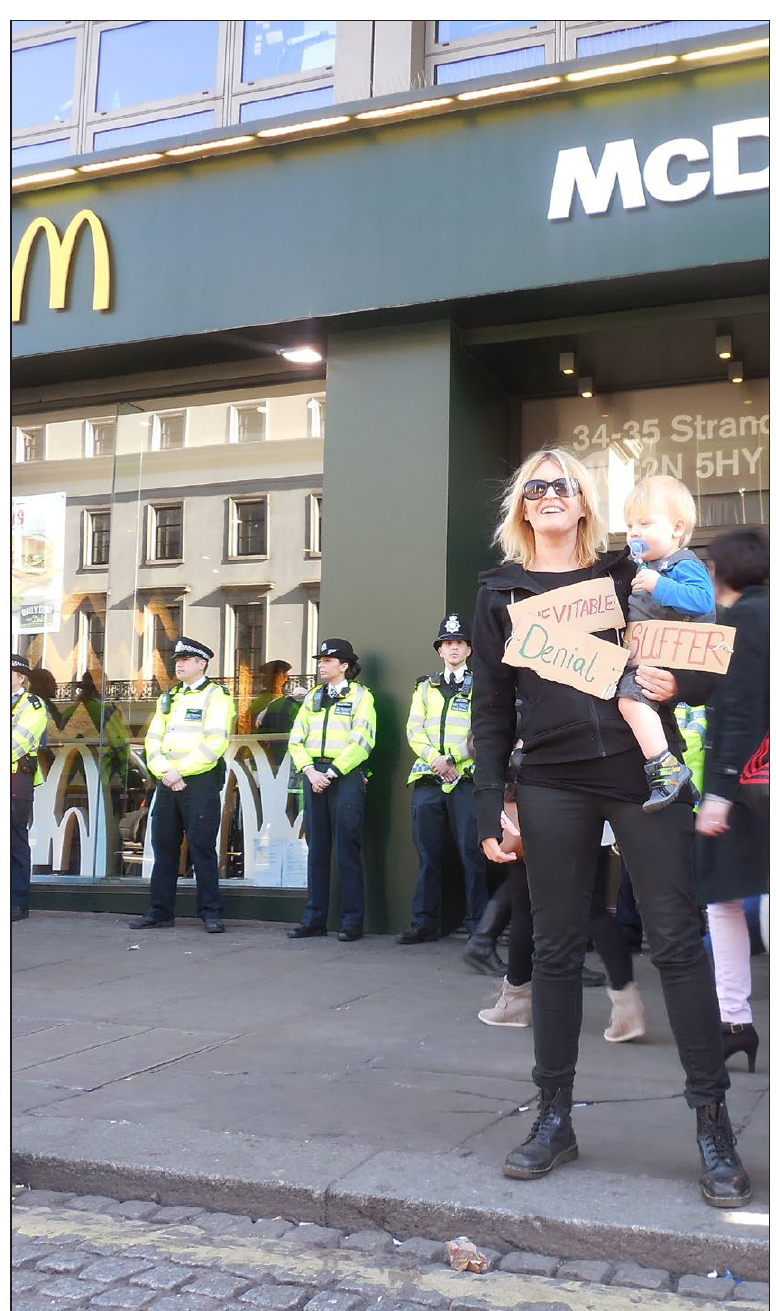
Figure 39: Lena Šimi ć , Lena and James at Time to Act Climate Protest , London 2015, Photo by Gary